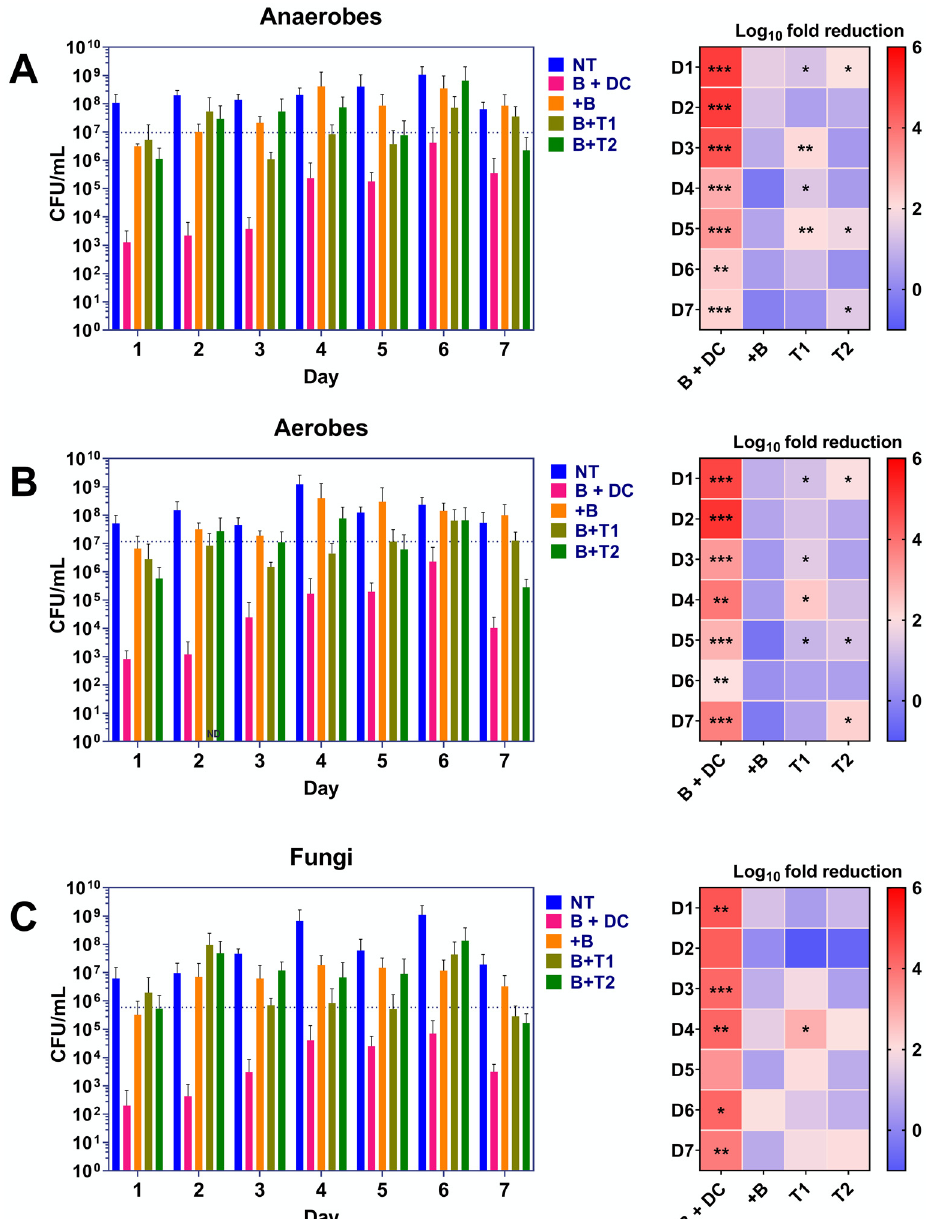
Figure 1. Viability counts for bacteria and fungi in the denture biofilm model. Denture biofilms formed on poly(methyl) methacrylate (PMMA) discs were treated for 7 days with six separate treatment modalities. These were non-treated controls (NT; blue bars), brushing with daily denture cleansing treatment (B + DC; pink bars), brushing only (+B; yellow bars), brushing with Colgate ® toothpaste (B + T1; light green bars) or brushing with Crest ® toothpaste (B + T2; dark green bars). The final treatment consisted of brushing with denture cleanser treatment on day 7 only (CFU counts for these are denoted by the dotted lines on the bar graphs). Results shown are representative of 2 individual experiments repeated with 3 separate replicates ( n = 6), each for anaerobic bacteria ( A ), aerobic bacteria ( B ) and fungi ( C ). Heatmaps show the average log 10 fold reductions in CFU counts relative to NT. Significance values are shown as follows; * p < 0.05, ** p < 0.01 and *** p < 0.001, all calculated relative to the NT using the Kruskal–Wallis test with Dunn’s post-test.